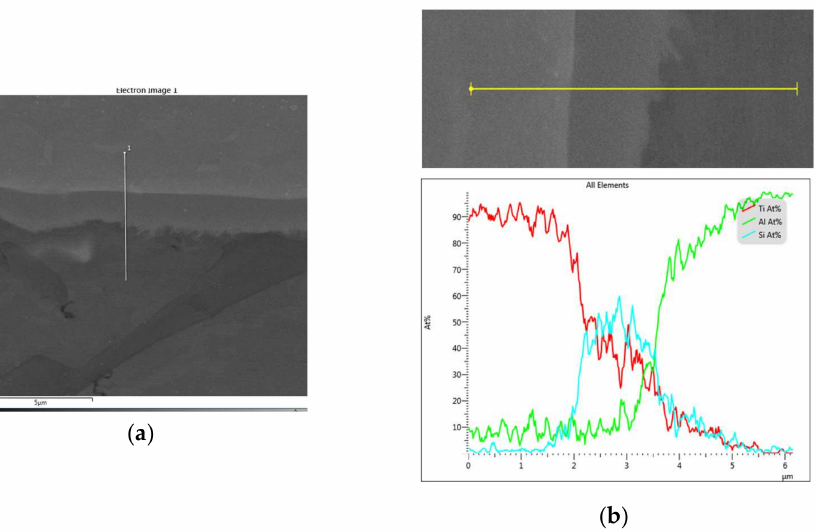
Figure 19. ( a ) SEM images (SEI) of 13/585 joint interface at the active part; ( b ) EDS line position and analysis of the interface in ( a